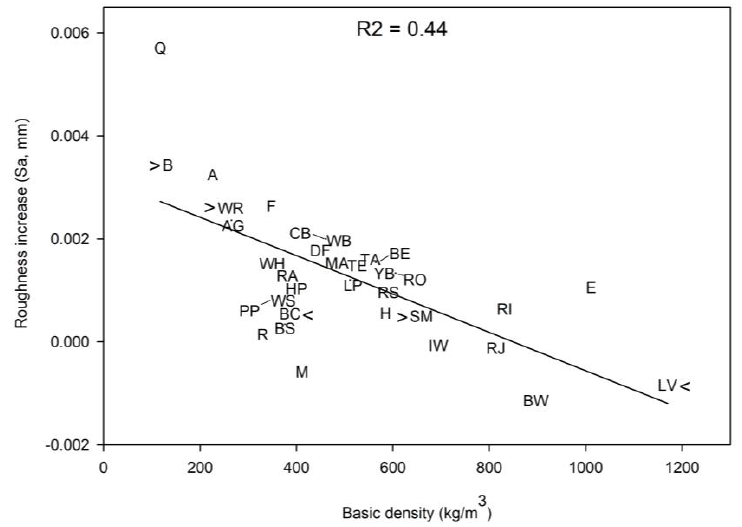
Figure 1. Relationship between density of woods and grain raising defined as the increase in surface roughness after sanding and wetting and air drying. Wood species can be identified using the abbreviations in Table 1. Values for roughness increases of some wood species were similar and their abbreviations overlapped. In these cases the precise numerical values for roughness increases are indicated by a period (.). In four cases an oblique line is drawn from the period to the abbreviated species name.